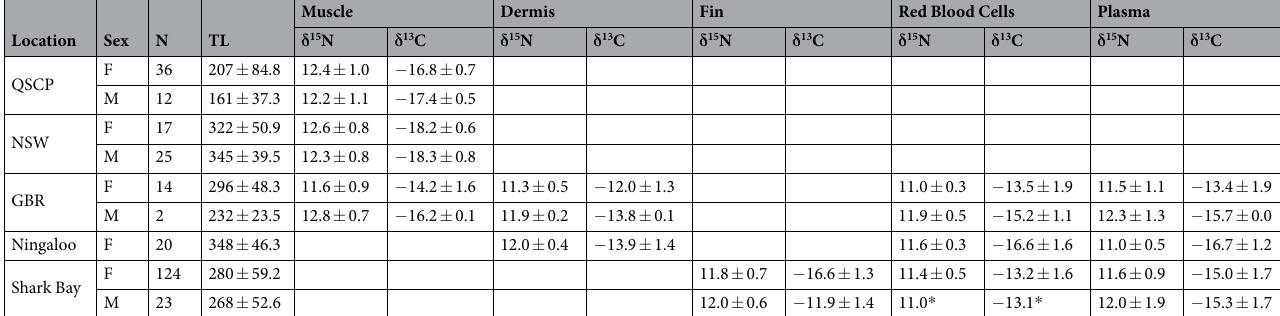
Table 1. Mean and standard deviation (SD) stable isotopic composition of tiger sharks sampled in the Queensland Shark Control Program (QSCP), New South Wales (NSW) the Great Barrier Reef (GBR) and Ningaloo and Shark Bay for each sex (F = female, M = male). δ 15 N and δ 13 C given in parts per mill (‰). N = number of samples, TL = mean total length (cm) ± SD. * n =